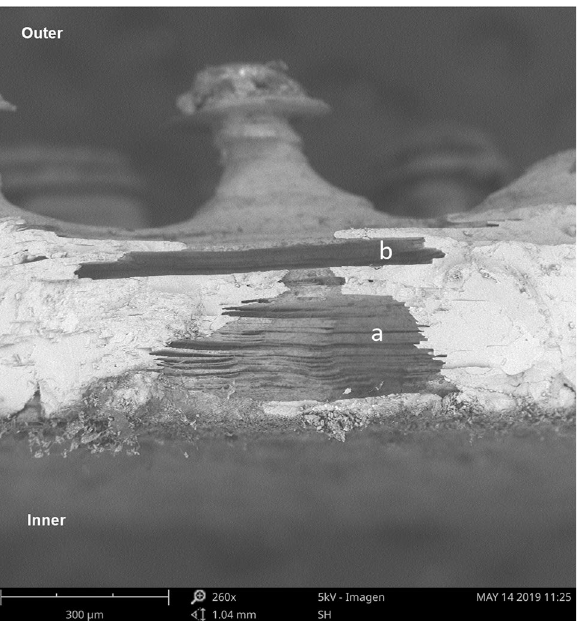
Figure 3. Radial view of the eggshell showing in detail the air chamber under SEM (Scanning Electron Microscope). (a) The cone of the pore canal growing to the external surface and connected with (b) the intracascaral